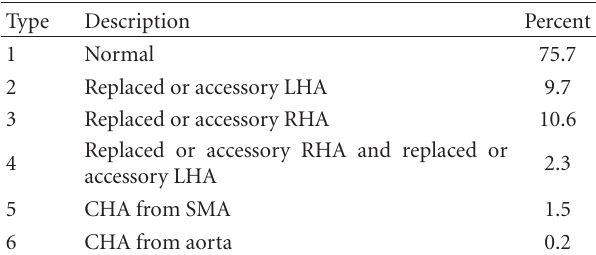
Table 2: Hiatt’s classification of hepatic arterial